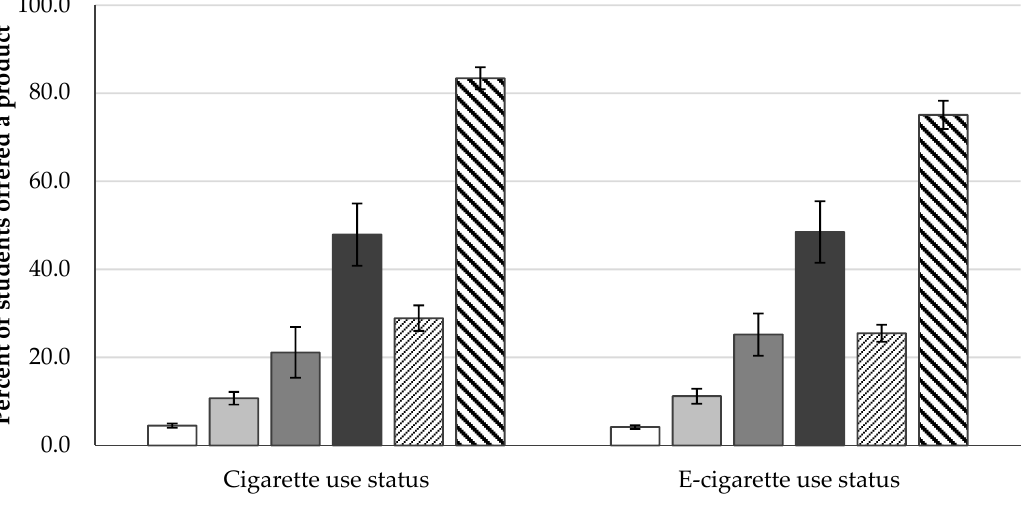
Figure 1. High school students who reported being offered cigarettes and e-cigarettes in the last 30 days according to their responses to measures of intentions to future use and current product use, 2015–16 California Student Tobacco Survey ( n = 40,137)